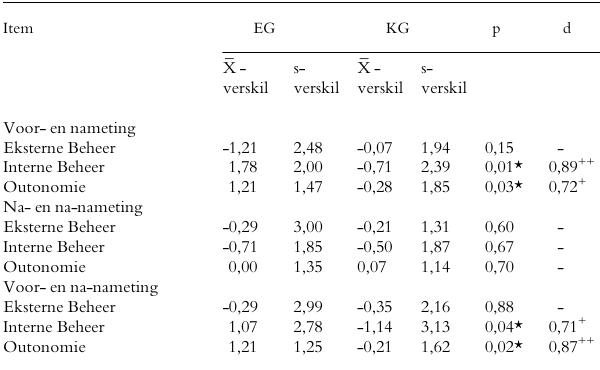
TABEL 2 VERSKILLETUSSEN DIEVOORENNAMETINGSVAN